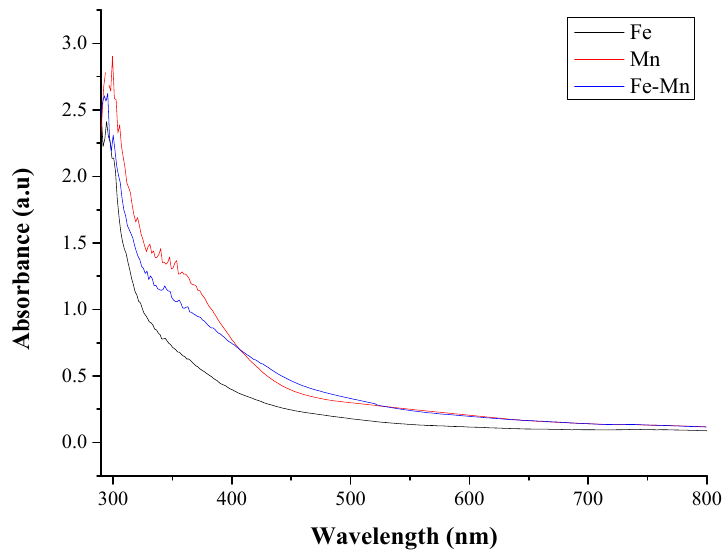
Figure 1. UV-visible spectra of Fe, Mn and Fe-Mn NPs.